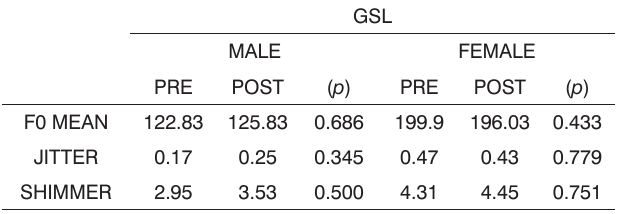
Table 4. Mean fundamental frequency (F [ ε ], e of jitter and shimmer, before and after phonation into a straw exercises, according to the group without lesions (GSL) and gender.